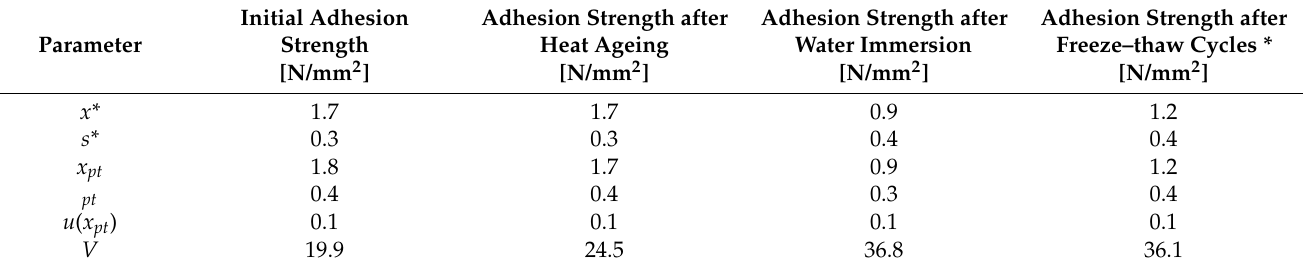
Table 5. The value of statistical parameters calculated following ISO 13528 for measurements of CTA initial tensile adhesion strength, tensile adhesion strength after heat ageing, tensile adhesion strength after water immersion, and tensile adhesion strength after freeze–thaw cycles.